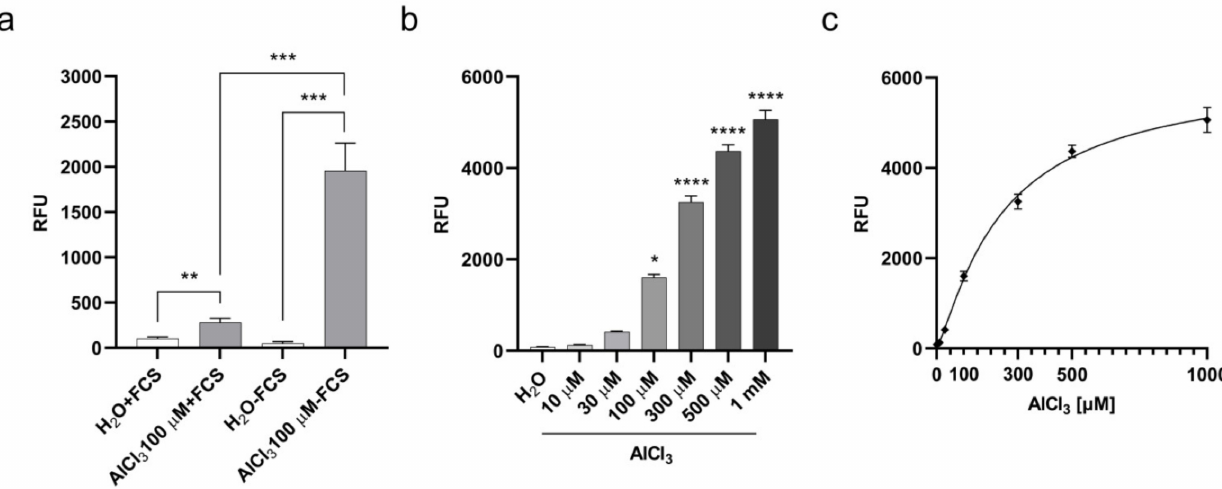
Figure 1. Aluminum absorption in V79 cells upon 3 h of exposure. ( a ) V79 cell aluminum absorption during 3 h in the presence or absence of 10% FCS. Bars represent the mean ± SEM Lumogallion relative fluorescence units (RFU) of five independent experiments each performed in octuplicate. (**) p -value < 0.01; (***) p -value < 0.001 (Two-tailed Nested T -test). ( b ) Dose-dependent aluminum absorption by V79 cells during 3 h, in the absence of FCS. Bars represent the mean ± SEM Lumogallion RFU of three independent experiments each performed in octuplicate. (*) p -value < 0.05; (****) p -value < 0.0001 (One-way ANOVA with Dunnett’s correction). ( c ) Correlation between AlCl 3 concentration in serum-free culture medium and cell-associated Lumogallion fluorescence. Non-linear regression curve between medium AlCl 3 concentration and cell-associated Lumogallion fluorescence intensity. Diamonds represent means ± SEM of the three independent experiments shown in ( b ). R squared =